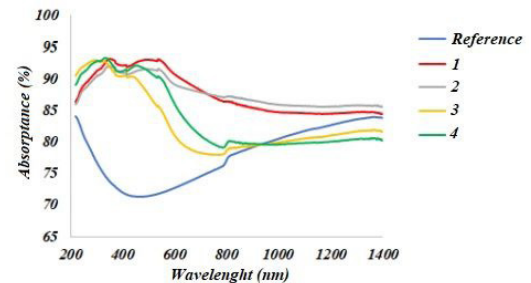
Figure 2. UV-Vis absorbance spectroscopy of ilmenite films deposited on 304 stainless steel substrates.